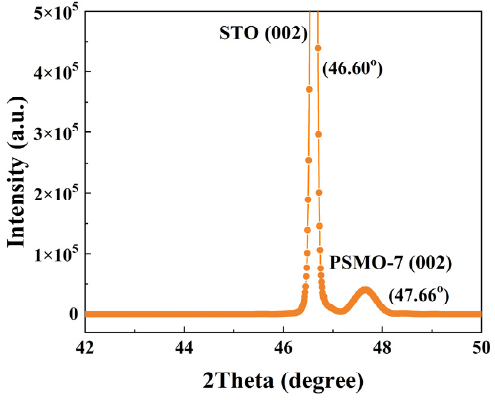
Figure 1. The ω -2 θ scan of the (002) diffraction plane of the PSMO-7 thin film grown on (001)-oriented SrTiO 3 .